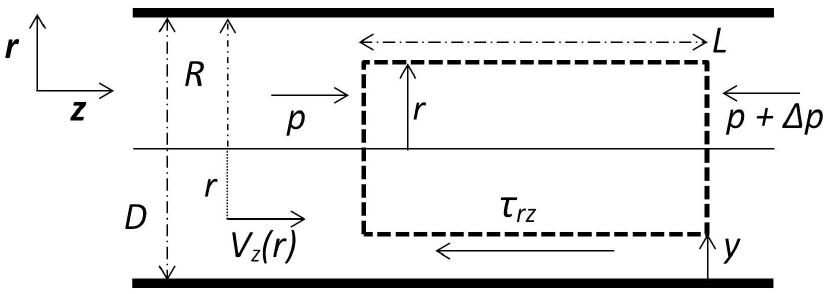
Figure 2. A schematic of a circular horizontal